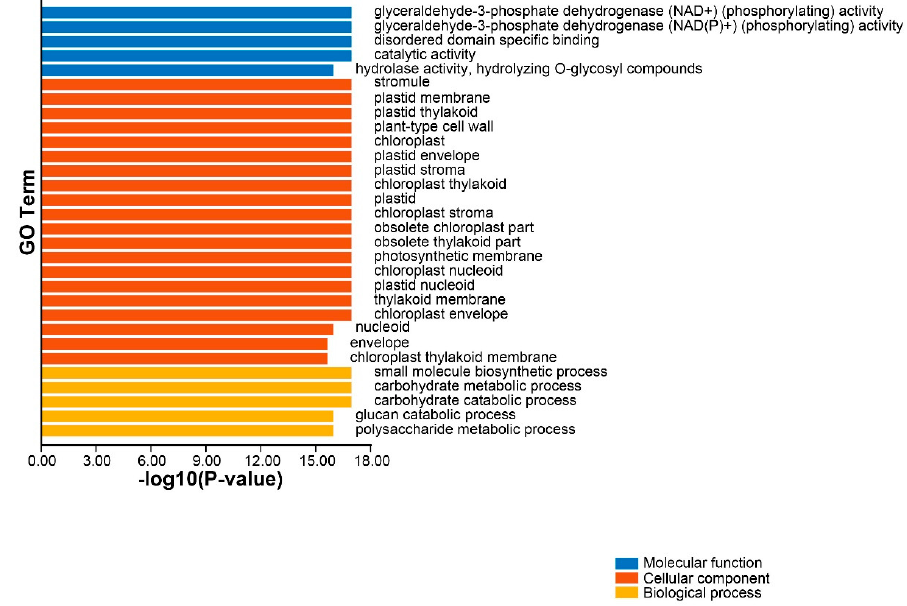
Figure 8. GO enrichment analysis of all differentially expressed genes (DEGs) in basil under heat stress.